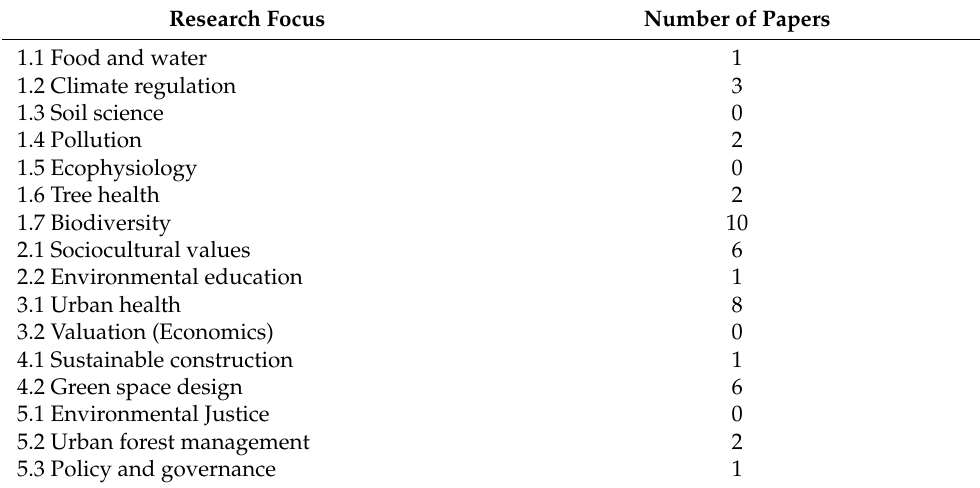
Table 2. Distribution of articles based on research focus ( n =